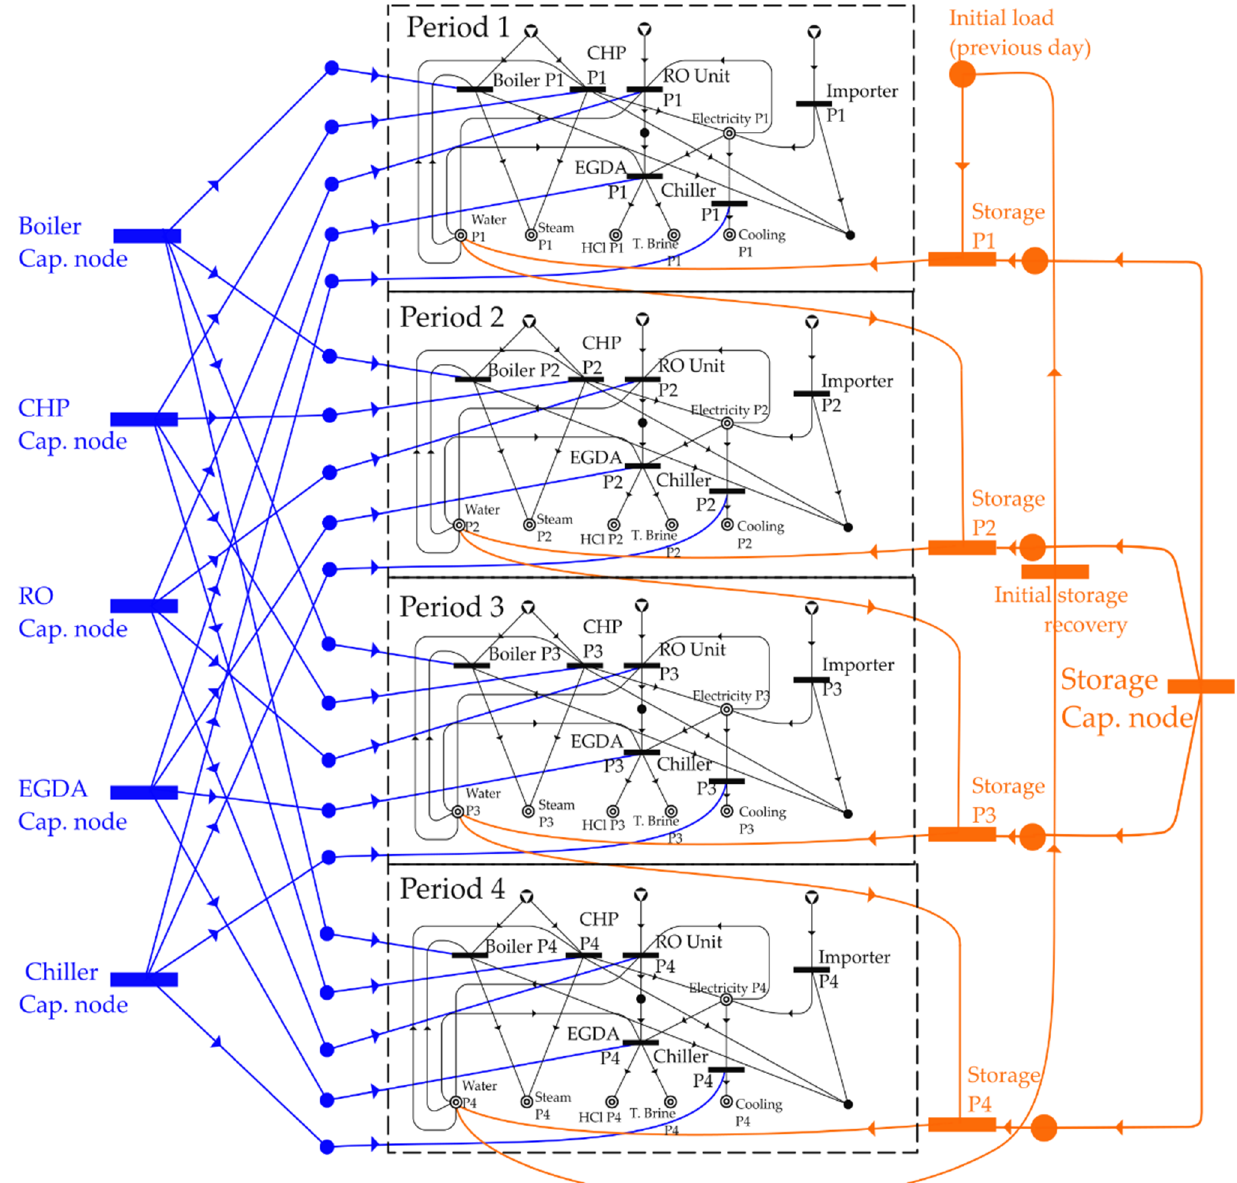
Figure 4. P-graph representation of case study for 4 periods.